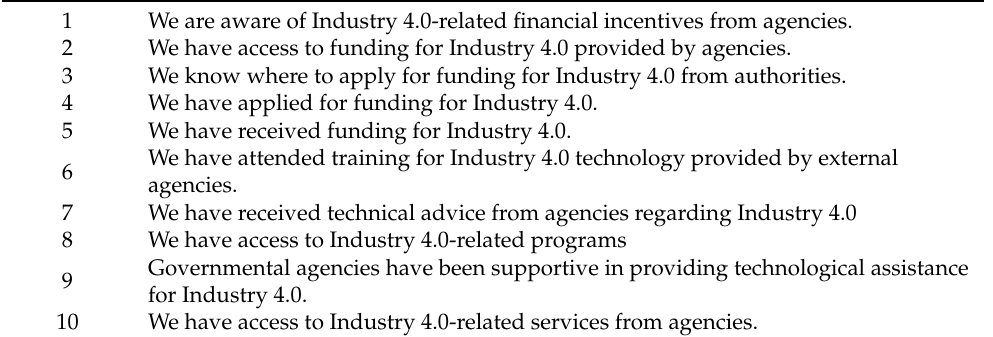
Table 4. Measurement items for financial support and technological support.